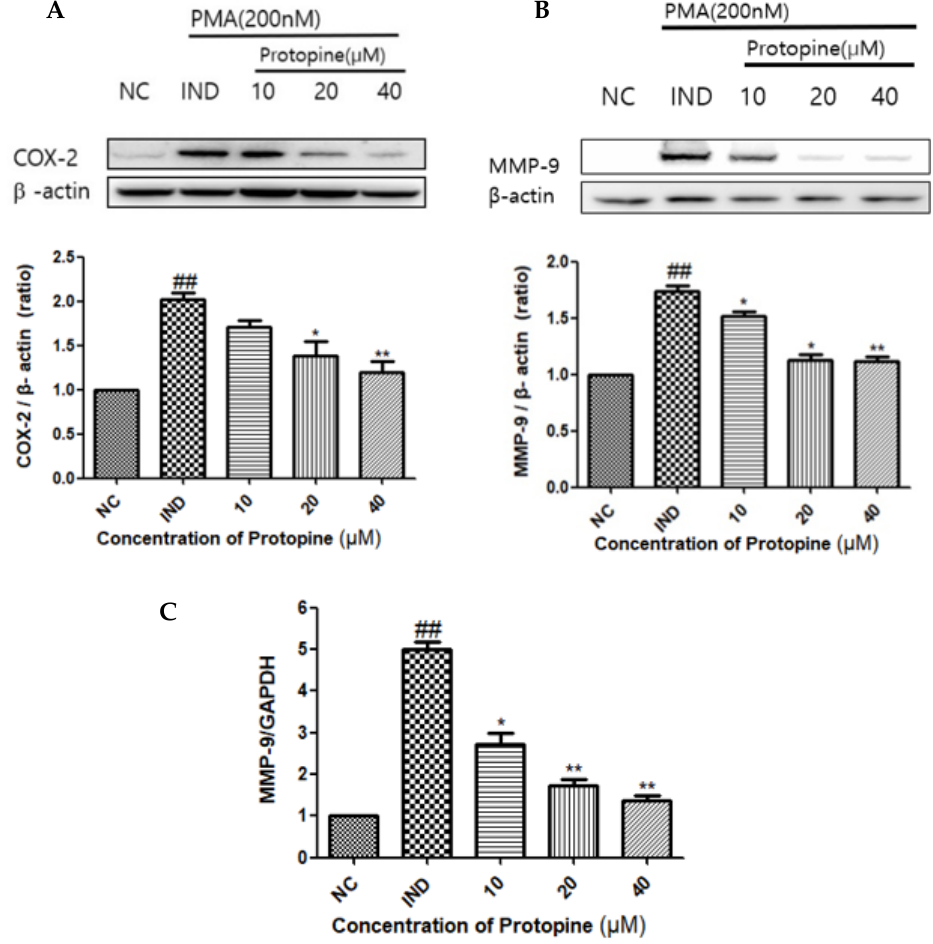
Figure 4. Protopine regulated COX-2 and MMP-9 in PMA-stimulated HepG2 cells. ( A ) COX-2, confirmed by Western blot, increased expression during the PMA treatment and decreased in a concentration-dependent manner upon the protopine treatment. ( B ) MMP-9, confirmed by Western blot, increased the expression when treated with PMA, and showed a high inhibition rate when treated with 40 uM of protopine. ( C ) MMP-9 mRNA levels were determined by RT-PCR analysis. MMP-9 showed the highest inhibition rate even at the mRNA level when treated with 40 μ M protopine. Results are presented as the mean ± SD. ## p < 0.01, indicating a significant difference from the control. * p < 0.05, ** p < 0.01, indicating a significant difference from the PMA group. NC, normal control; IND, inducer.